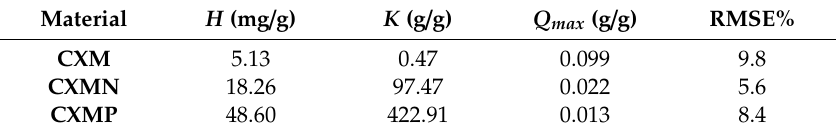
Table 3. Parameters obtained for the solid–liquid equilibrium (SLE) model from adsorption isotherms of cannabidiol (CBD) in an aqueous solution of pH = 7 onto carbon xerogel microspheres (CXMs) and CXMs functionalized with melamine (CXMN) and phosphoric acid (CXMP) at 25 ◦ C. The H